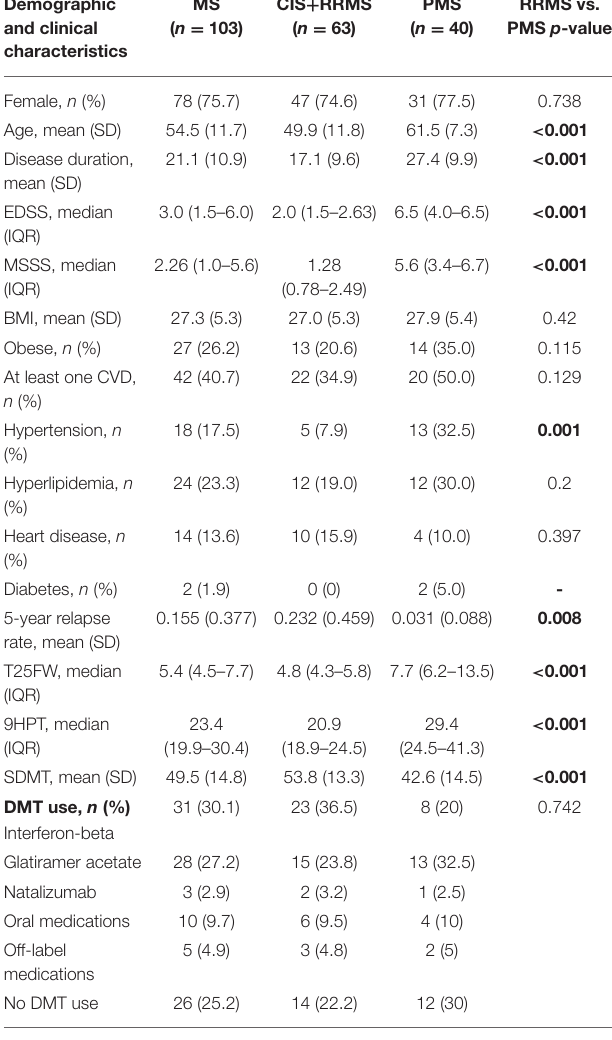
TABLE 1 | Demographic, clinical, and cognitive characteristics of the study